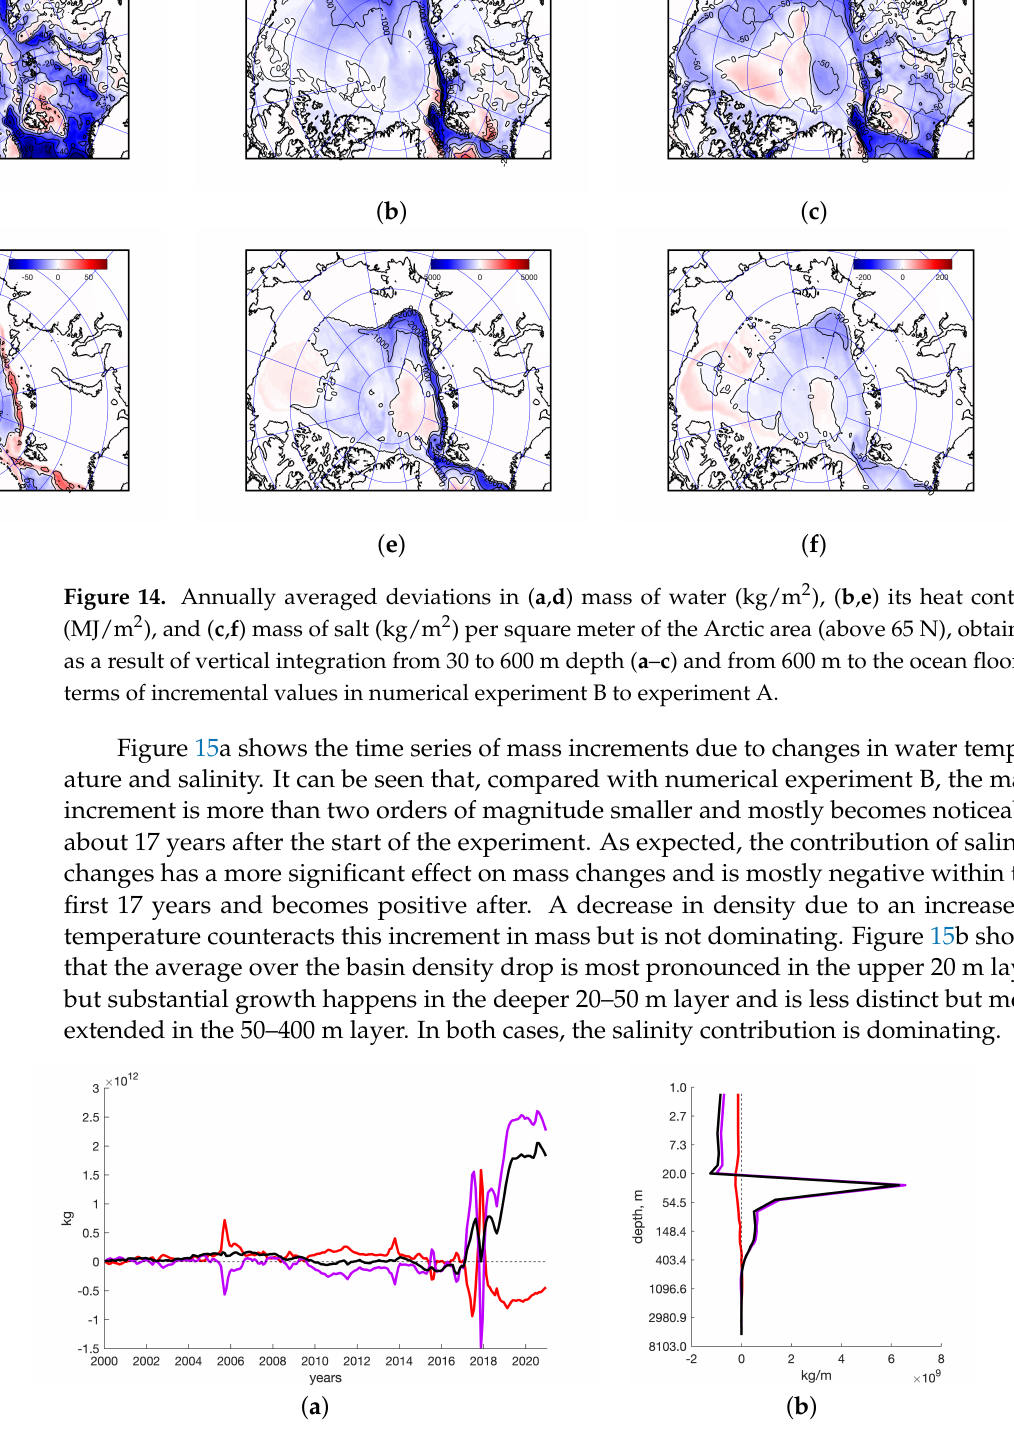
Figure 15. The difference in mass (black curves), heat (red curves), and salt (magenta curves) content in terms of the increment in the mass of water (kg) in the Arctic (above 65 N): ( a ) time series of the whole content, ( b ) vertical distribution averaged over time in terms of incremental values in numerical experiment C1 to experiment